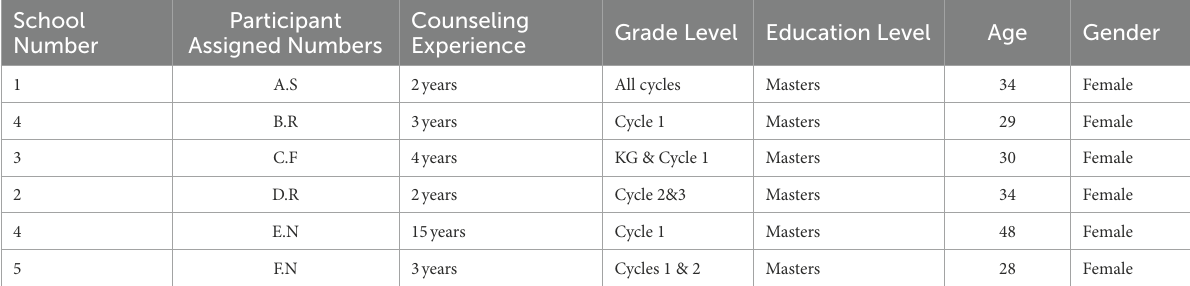
TABLE 2 Demographic information of school participants in focus group discussion. School